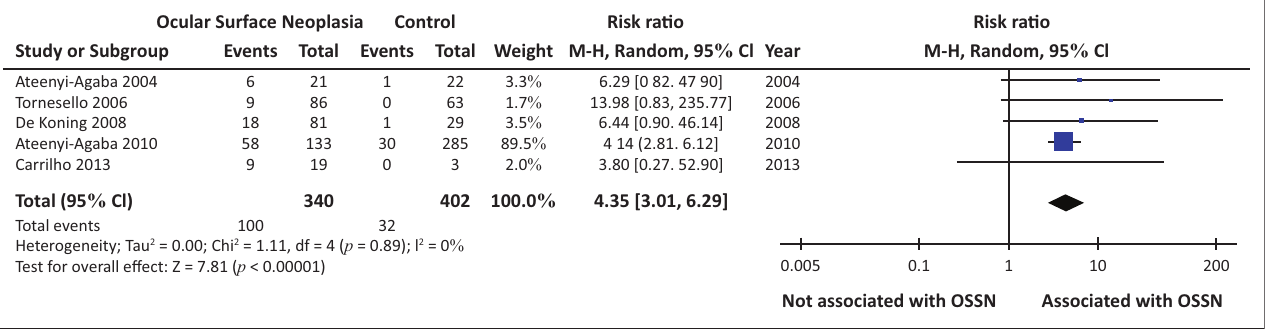
FIGURE 4: Forest plot showing the risk ratio for cutaneous human papilloma virus as an association with ocular surface squamous neoplasia. The overall risk ratio was 4.35 and 95 % CI: 3.01–6.29, with a low heterogeneity of